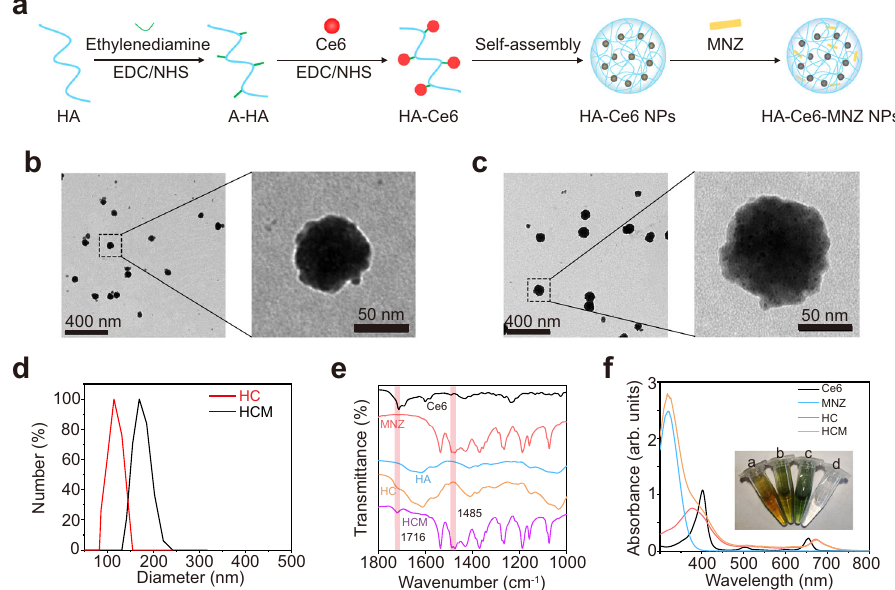
Fig. 2 Preparation and characterization of HCM NPs. a Schematic illustration of the preparation of HCM NPs (amine-functionalized HA (A-HA), 1-(3- dimethylaminopropyl)-3-ethylcarbodiimide hydrochloride (EDC), N-hydroxysulfosuccinimide sodium salt (NHS)). Transmission electron microscopy (TEM) images of HA-Ce6 nanoparticles (HC NPs) ( b ) and HCM NPs ( c ) with low magni fi cation (left) and high magni fi cation (right). Three independent experiments were performed and representative results are shown in b and c . d Hydrodynamic sizes of HC NPs and HCM NPs measured by dynamic light scattering (DLS). e Fourier transformed infrared (FT-IR) spectra of Ce6, MNZ, HA, HC NPs, and HCM NPs. f Ultraviolet-visible-near infrared (UV-vis-NIR) spectra of Ce6, MNZ, HA, HC NPs, and HCM NPs. Inset: photographs of different solutions (a: HC NPs; b: HCM NPs; c: Ce6; d: MNZ). Source data are provided as a Source Data fi